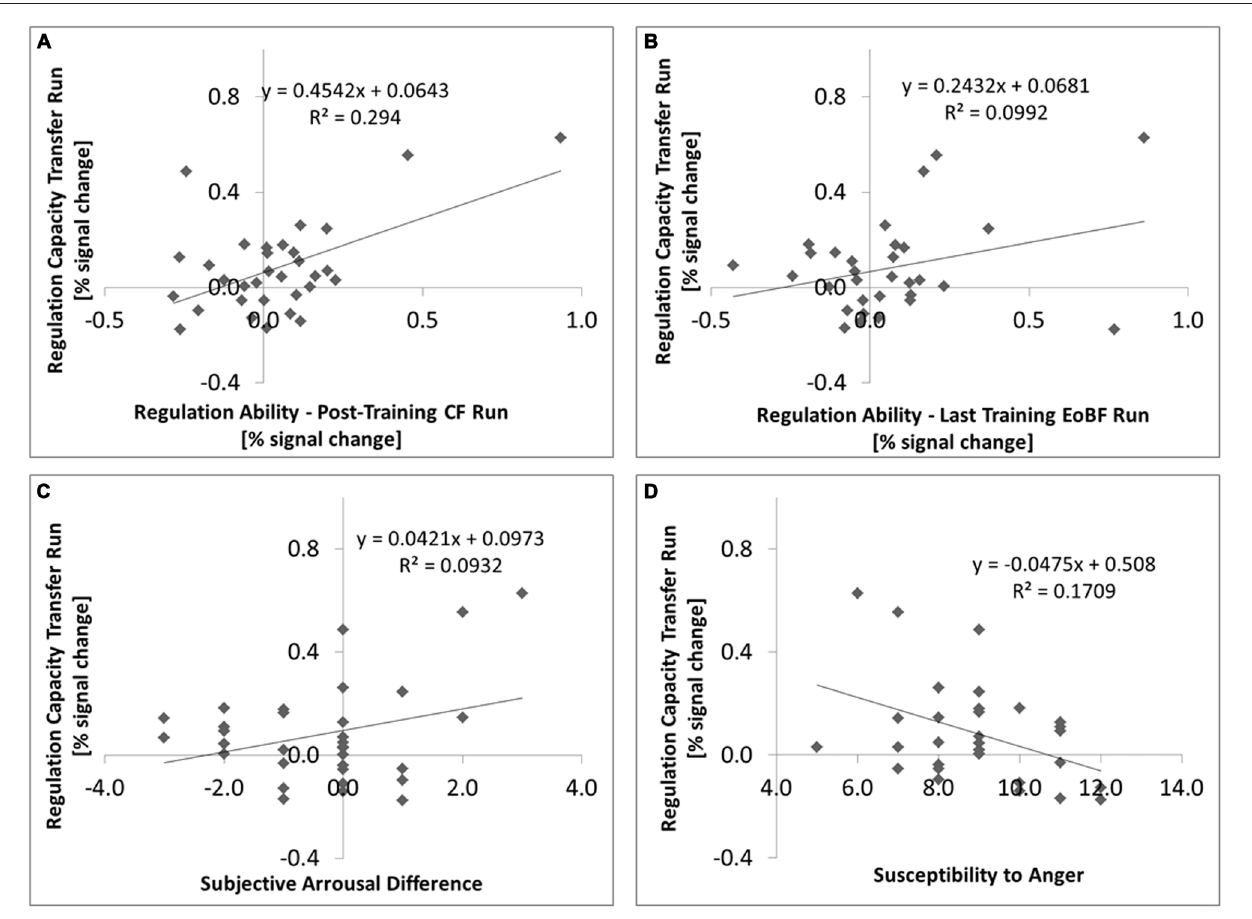
FIGURE 3 | Individual regulation capacity, which refers throughout the manuscript to the BOLD model contrast “UP” against “DOWN” in the post-training transfer run, is plotted as a function of various parameters: (A) vs. regulation ability in the post-training continuous feedback run ( N = 32, P = 0.001); (B) vs. regulation ability in the EoBF run of the last (3rd) training session ( N = 31, P = 0.042); (C) vs. the difference in subjective arousal ratings between the up-regulation and down-regulation conditions for the post-training session ( N = 32, P = 0.045); (D) vs. the Emotional Contagion “Susceptibility to Anger” subscale ( N = 31, P = 0.019). Fitting coefficients and the coefficients of determination are